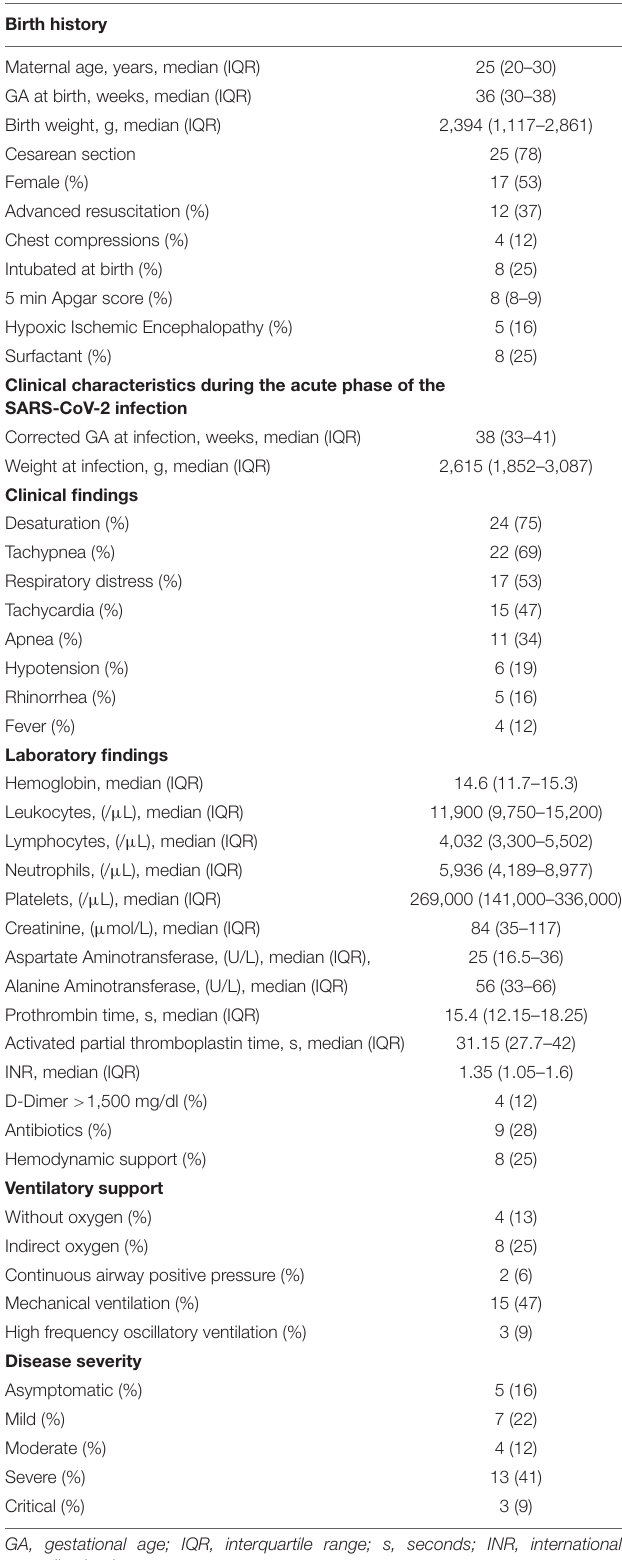
TABLE 1 | Demographics, clinical, and laboratory findings during the acute phase of the SARS-CoV-2